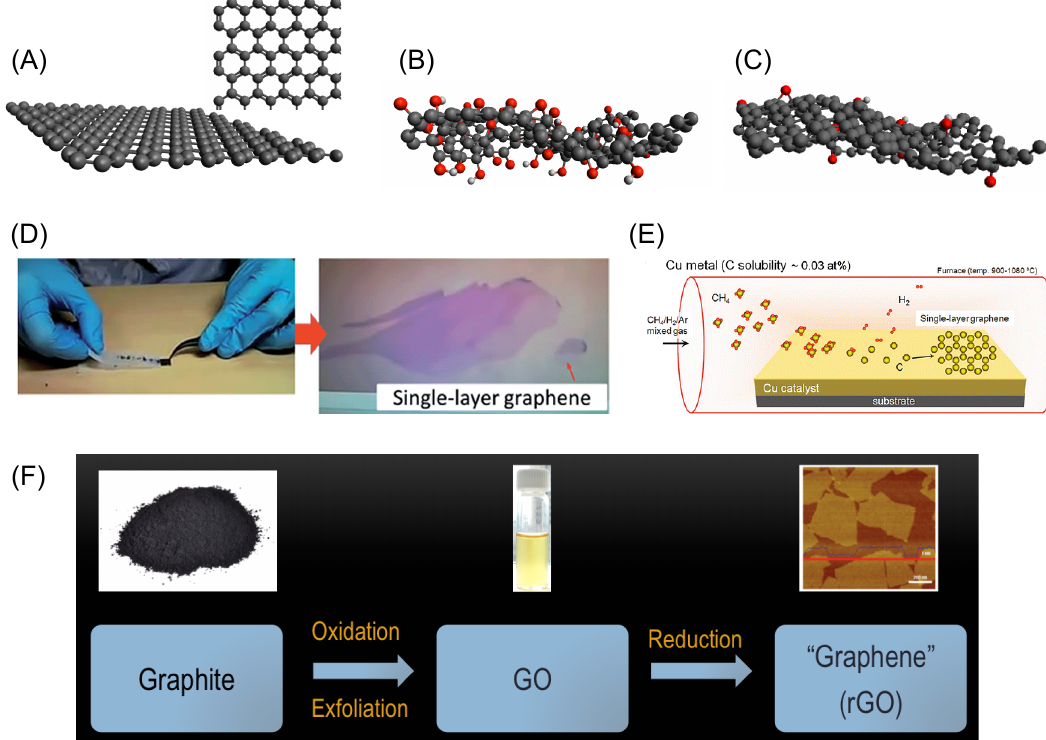
Figure 1. ( A ) The hexagonal honeycomb structure of graphene. ( B ) The amorphous structures of graphene oxide and ( C ) reduced graphene oxide. Black, red, and white spheres represent carbon, oxygen, and hydrogen atoms, respectively. Schematics of the synthesis of graphene monolayers using ( D ) the mechanical exfoliation method, ( E ) chemical vapor deposition method, and ( F ) the solution-based method. Figures reproduced with permission from: ( D ) [10], RSC c (cid:13) Springer Japan c